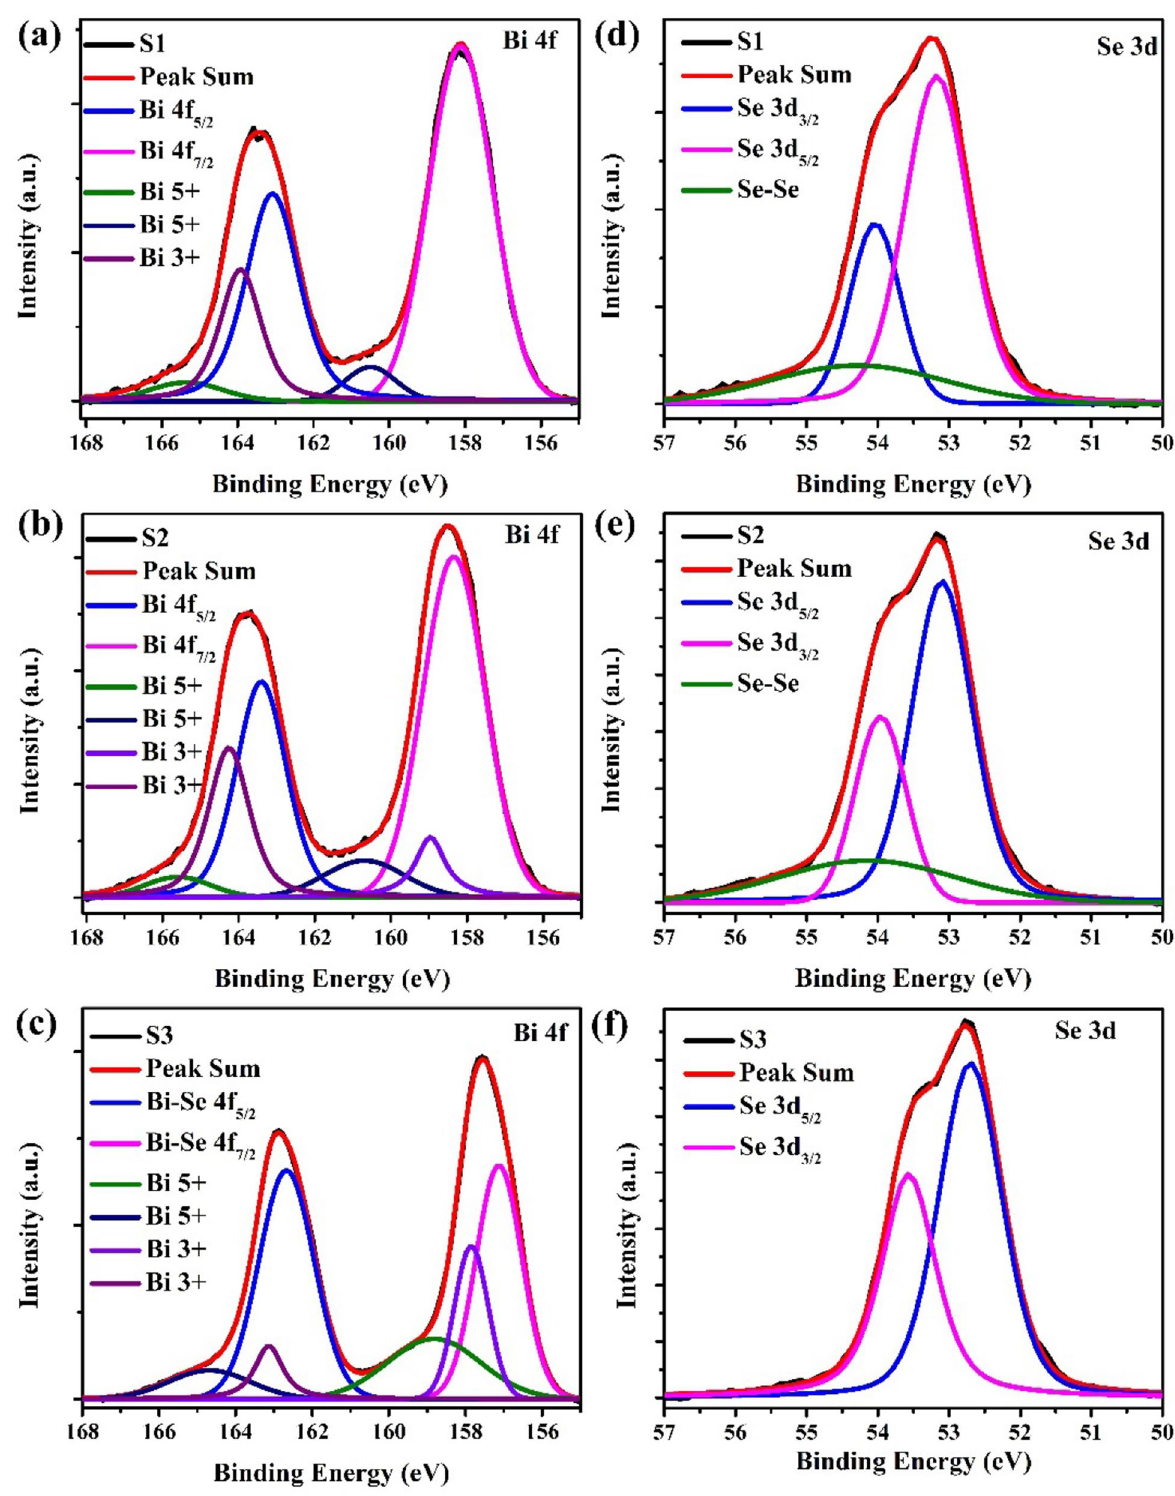
Figure 4. XPS spectra of Bi 2 Se 3 thin films: Bi 4f core level spectra in the binding energy range from 155 to 168 eV for samples S1 ( a ), S2 ( b ) and S3 ( c ). Se 3d core level spectra in the binding energy range of 50 to 57 eV for samples: ( d ) S1, ( e ) S2 and ( f )